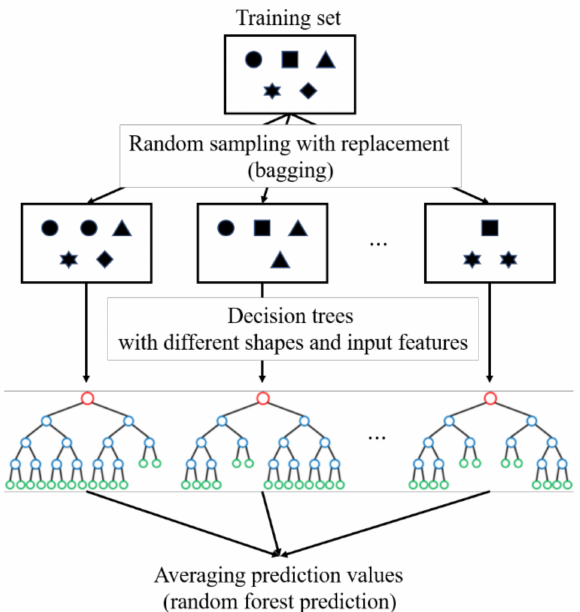
Figure 8. Principle of a random forest (RF). Bagging is the process of data sampling from a training set, randomly. Sampled datasets are used to make different kinds of decision trees (DTs). In the prediction phase, all the values predicted from various DTs are averaged and it is called the prediction value of